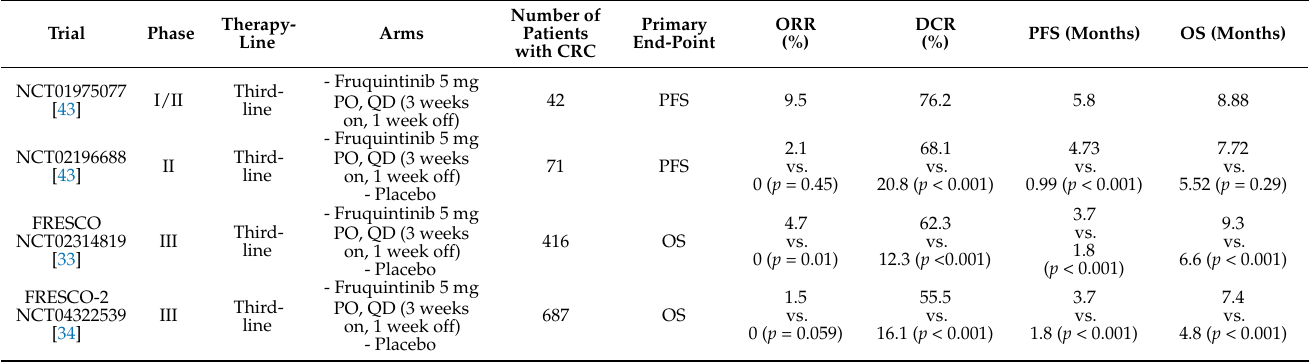
Table 1. Summary of the main trials of fruquintinib in colorectal